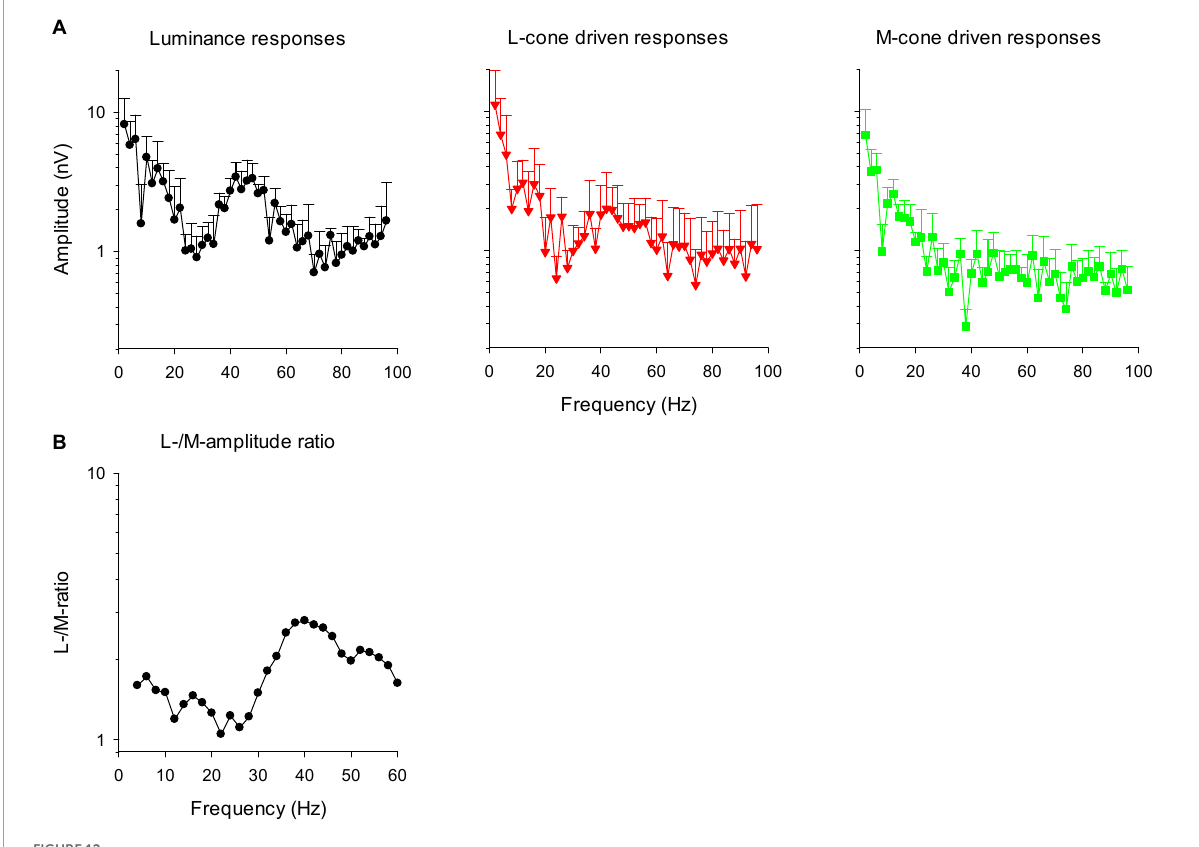
FIGURE12 (A) Amplitude plots (mean + 1 SD) of the IRFs in the frequency domain after FFT (resulting in modulation transfer functions; MTFs). (B) The ratio of L- to M-cone driven response amplitudes as a function of temporal frequency. The data were smoothed by averaging the L-/M-ratio at the indicated frequency with those at the two adjacent